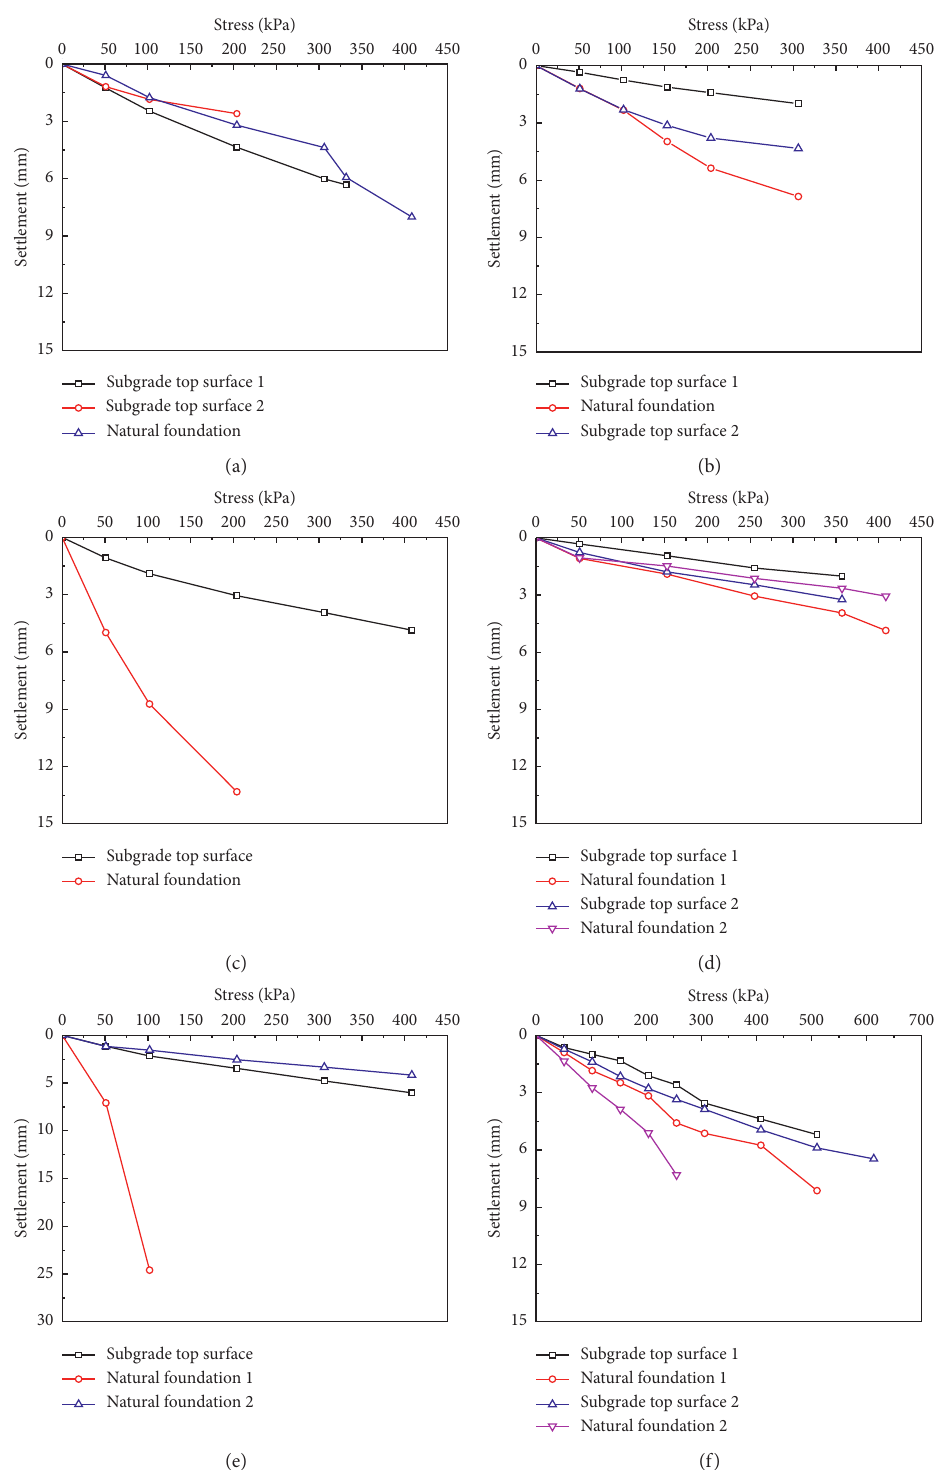
Figure 7: Results of the p - s curve in each test area. (a) Area 1. (b) Area 2. (c) Area 3. (d) Area 4. (e) Area 5. (f) Area